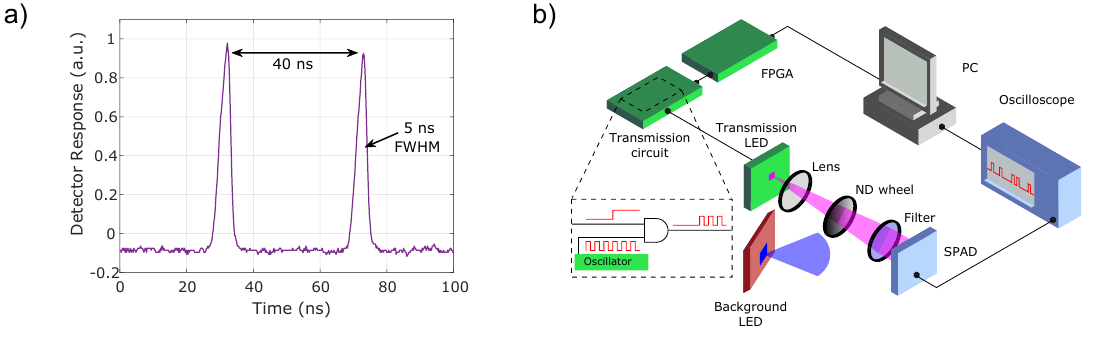
Figure 2. ( a ) Measured pulse pair from a micro-LED source. ( b ) Schematic of the experimental